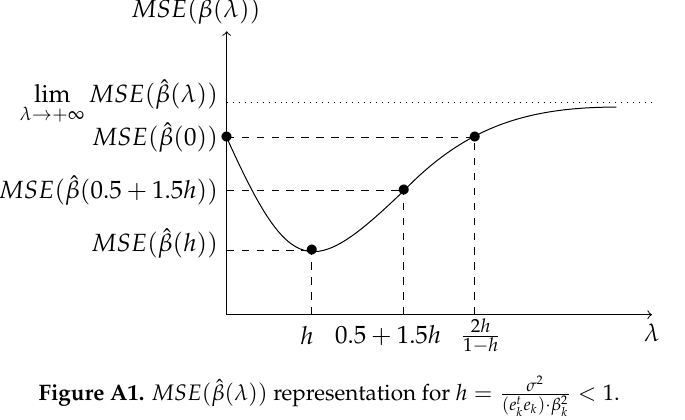
Figure A1. MSE ( ˆ β ( λ )) representation for h =